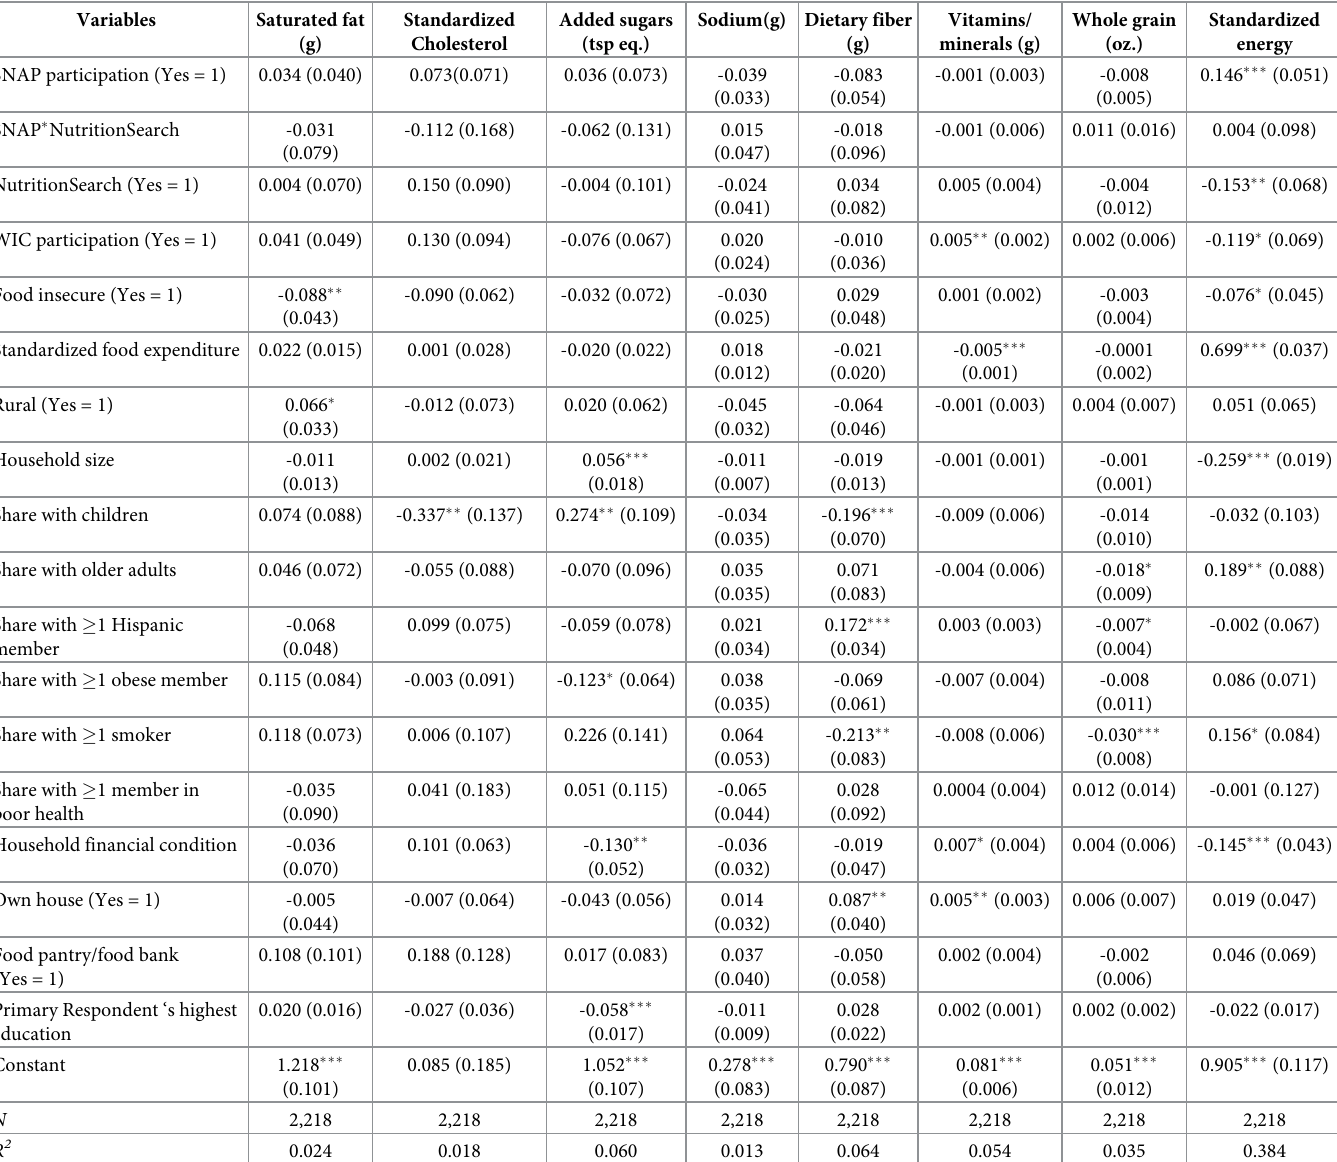
Table 5. Associations between covariates and nutrients densities (per 100 kcal of FAH purchases) and per capita energy acquired among low-income households.